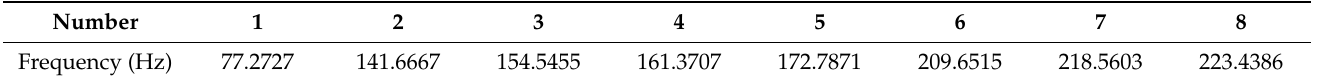
Figure 7. Frequency response: ( a ) shows the result of primary path. ( b ) shows the result of secondary path. Table 4. First eight characteristic frequencies of the given closed